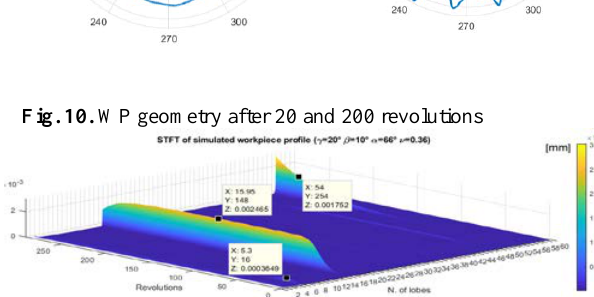
Fig. 11. Time-frequency analysis of WP